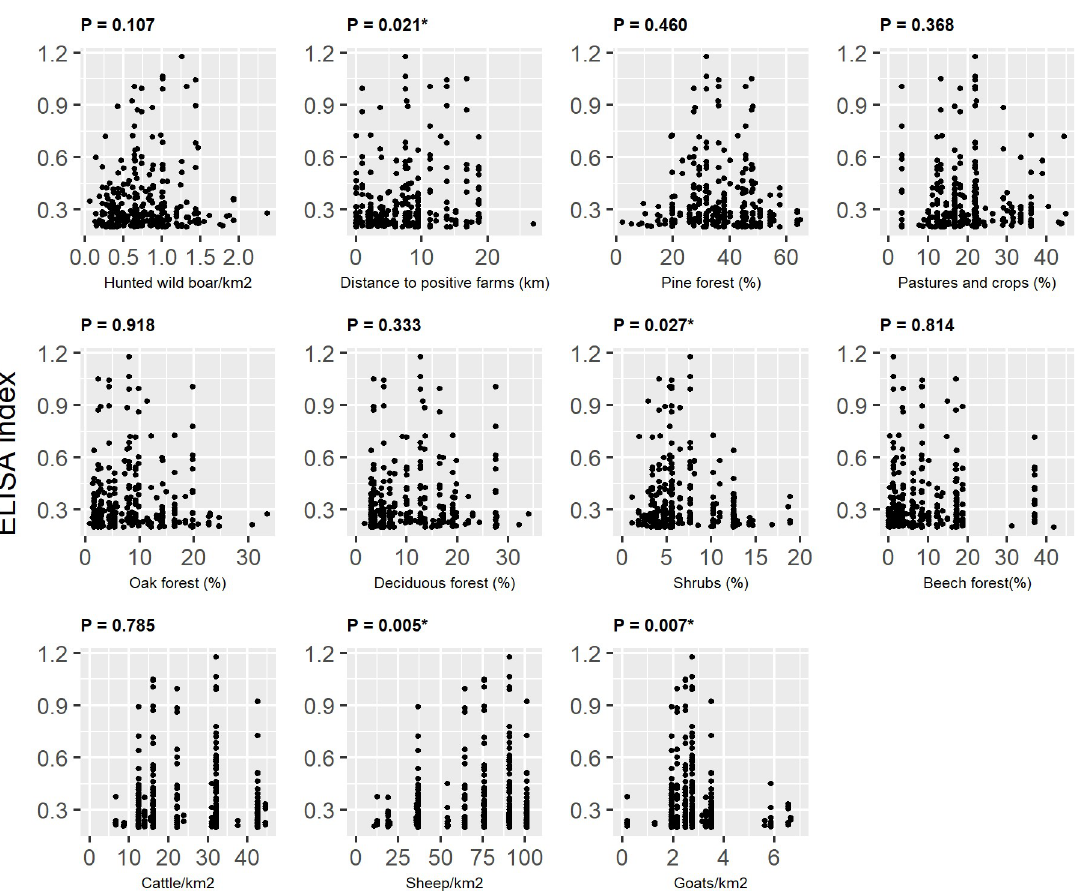
Fig 2. Descriptive statistics of the ELISA index of positive boars according to continuous variables. “ � ” indicates a significant association between the response and the explanatory variable at the univariate analysis (p < 0.05). Variables with a p-value lower than 0.25 were included in the gamma